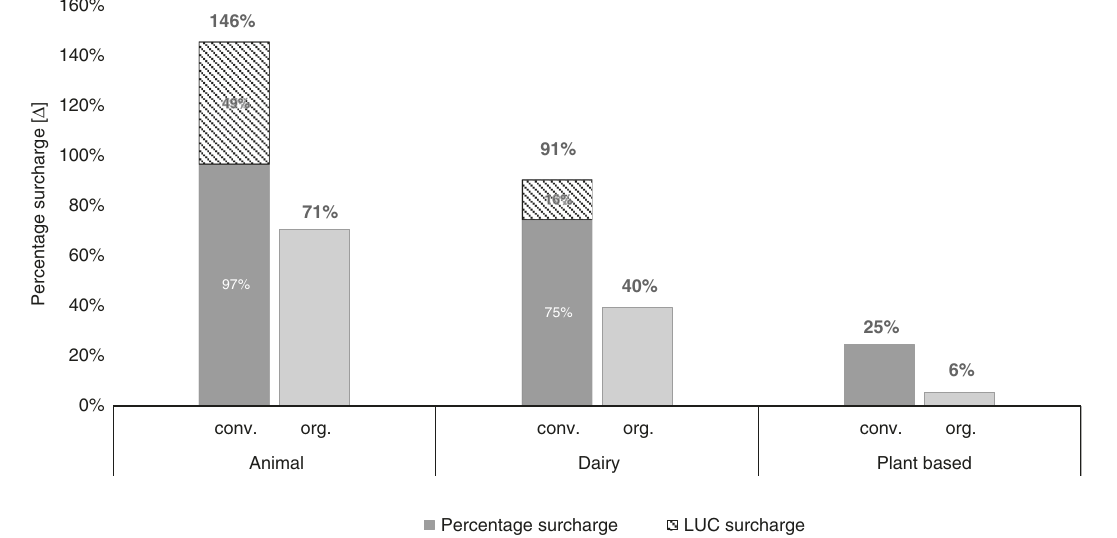
Fig. 2 Visualization of percentage price increases for broad food categories. Relative percentage price [ Δ ] increases for broad categories (animal-based, dairy, plant-based in the comparison between conventional and organic production) when externalities of greenhouse gas emissions are included in the producer ’ s price. For conventional production (animal-based and dairy), the surcharge from land-use change (LUC) emissions is highlighted separately. Source data are provided as a source data fi le.